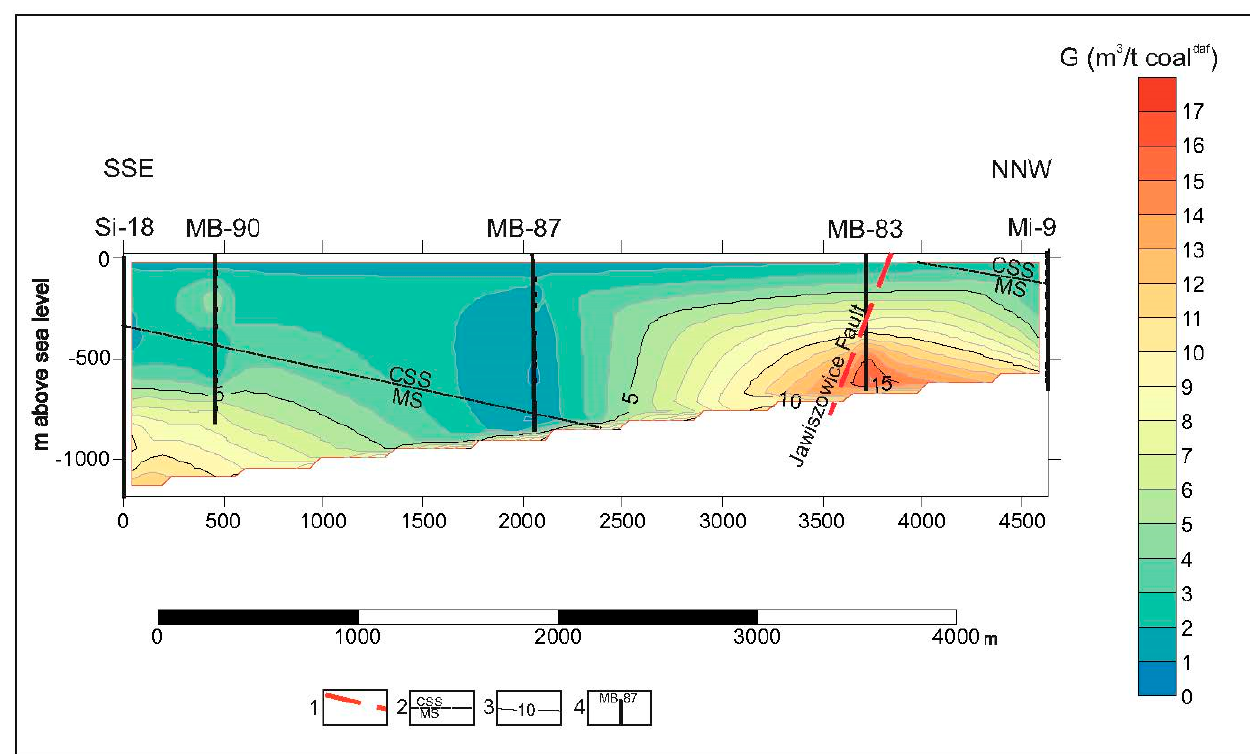
Figure 11. Cross-section across the Ć wiklice and Dankowice sub-areas; 1—Jawiszowice Fault, 2—boundary between the Cracow Sandstone Series (CSS) and the Mudstone Series (MS), 3—isoline of methane content G (m 3 /t coal daf ), 4—borehole.